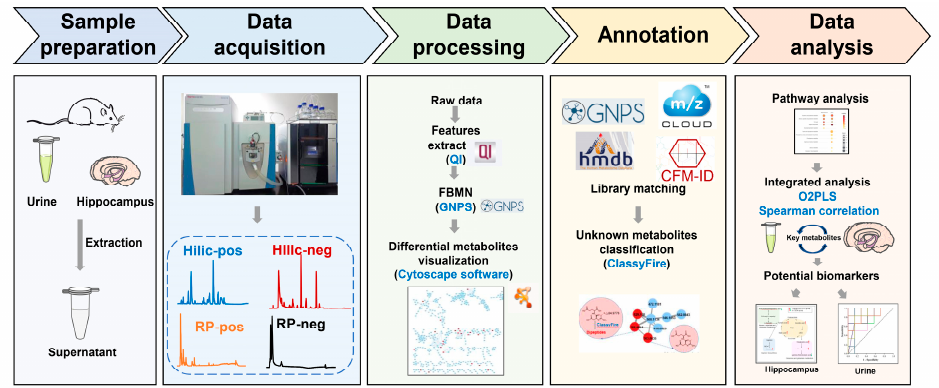
Figure 1. Overview of the study work fl ow.